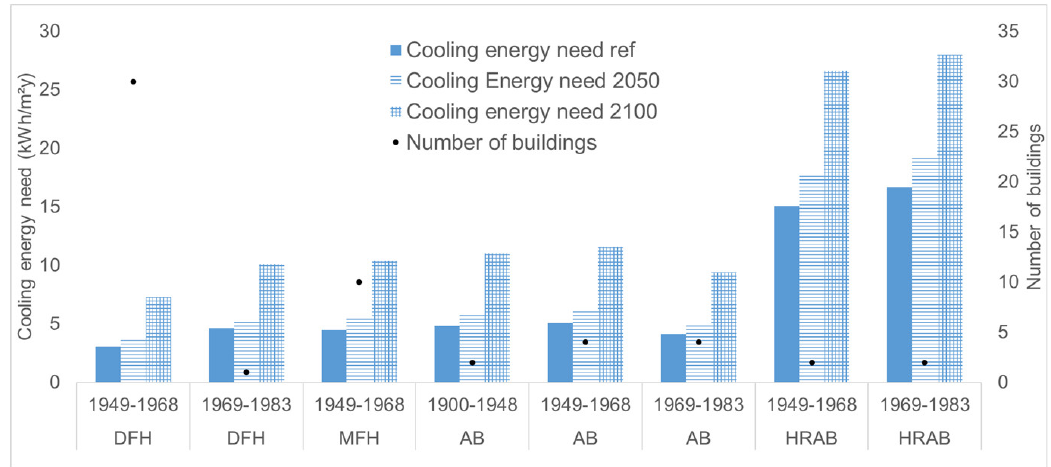
Figure 16. Impact of future climate change on specific cooling energy needs of different building typologies in an urban district in Karlsruhe.